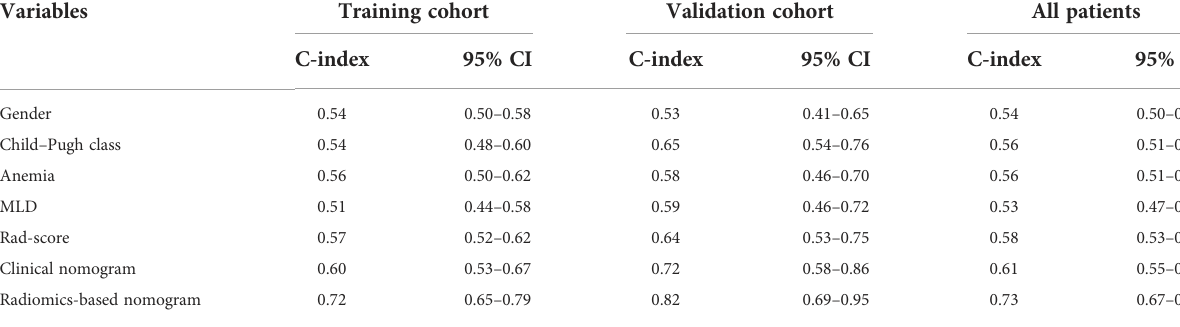
TABLE 8 C-indexes of signi fi cant features, clinical nomogram, and radiomics-based nomogram. Variables Training